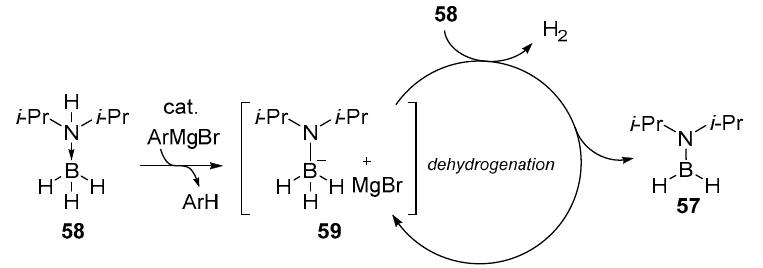
Figure 2. Proposed mechanism for dehydrogenation of DIPAB 58 .